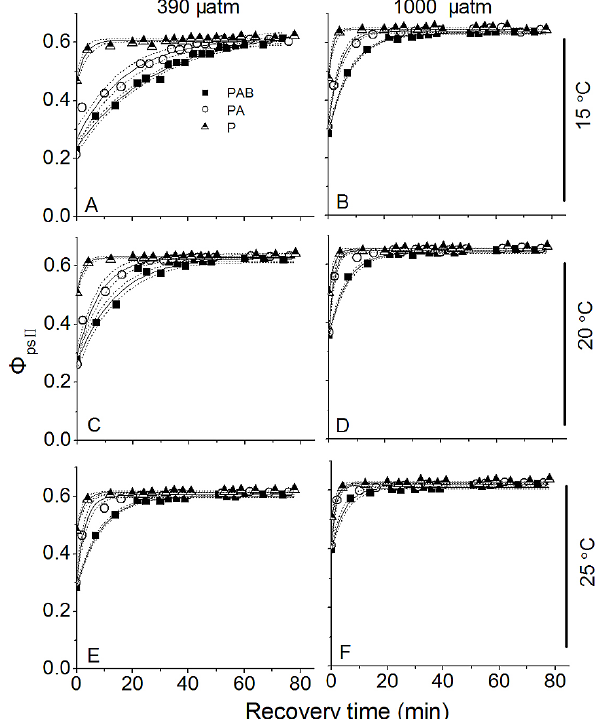
Fig. 5. Recovery of the effective photochemical quantum yield ( 8 PSII ) in the LC- ( A , C and E ) and HC- ( B , D and F ) grown cells of P. tricornutum after exposure to three radiation treatments – PAB (irradiated above 295 nm, black squares), PA (irradiances above 320nm, white circles) and P (irradiances above 395nm, half solid triangles) – at 15, 20 and 25 ◦ C. Solid lines represent the best fit while the broken lines represent the 95% confident limits.